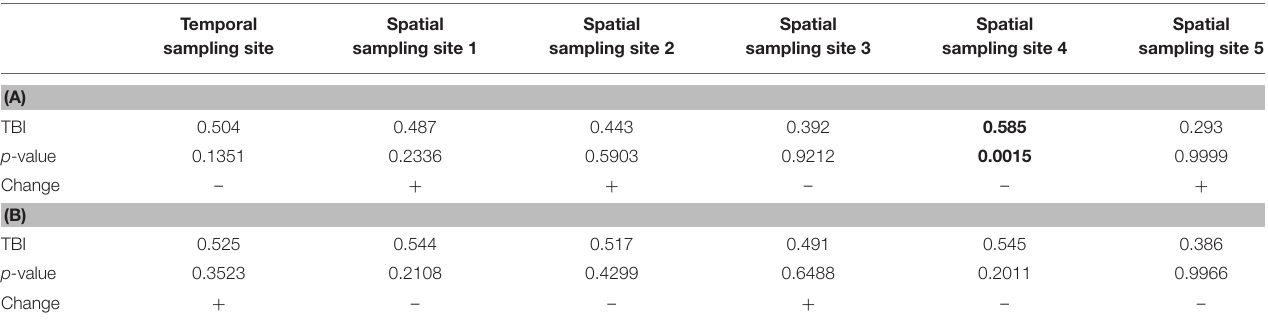
TABLE 3 | Temporal beta diversity according to temporal beta diversity indices (TBI) at our temporal sampling site and five spatial sites between (A) June 2017 and September 2017, and (B) September 2017 and May